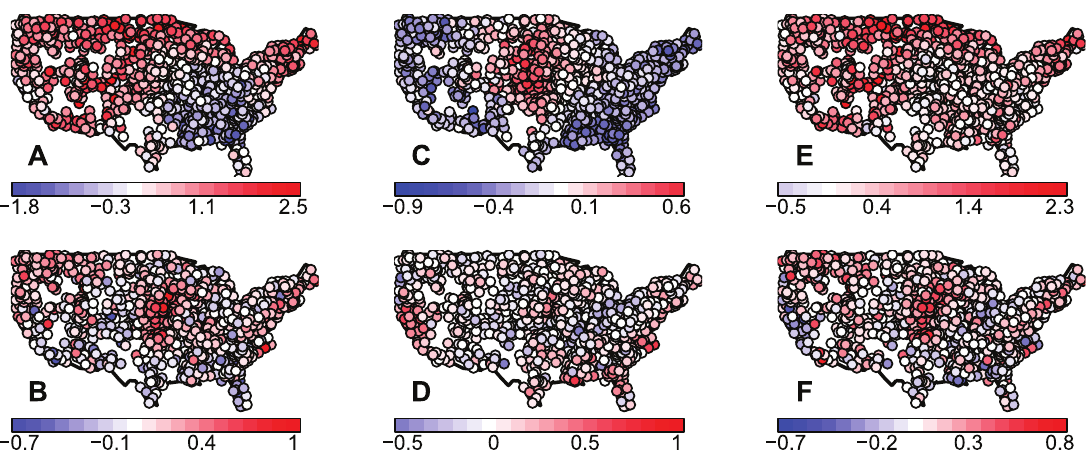
Figure 4. Relative changes in mean and standard deviation of climate variables in the United States. Both the mean and standard deviation of biologically important climate variables are changing; this figure indicates the relative magnitudes of these changes. If m 1 and sd 1 are the mean and standard deviation of winter temperature in a location for the period 1911–1945, and m 2 and sd 2 are the mean and standard deviation of winter temperature in the same location for the period 1976–2010, then: panel A shows m 2 { m 1 , the degree of change in environmental mean; panel C shows sd 2 { sd 1 , the degree of change in environmental standard deviation; and panel E shows j m 2 { m 1 j { j sd 2 { sd 1 j , which indicates the relative magnitudes of these changes and is positive when changes in mean exceed changes in standard deviation and negative otherwise. White corresponds to no change on A–D and to equal changes in mean and standard deviation on E–F. Environmental variables depicted are winter mean temperature (A, C, E) and total spring precipitation (B, D, F). Mean and standard deviation of total spring precipitation (B, D, F) use the square root of the precipitation values (Methods). Other weather variables are shown in Figure S1 in Section S8 in File S1. The main message here is that changes in the means of most environmental variables are slightly but not markedly bigger than changes in their standard